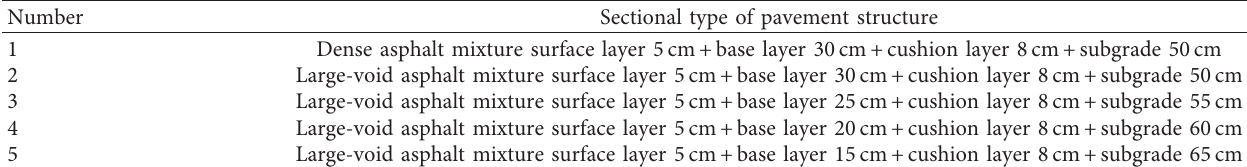
Table 2: Different pavement structure section types.